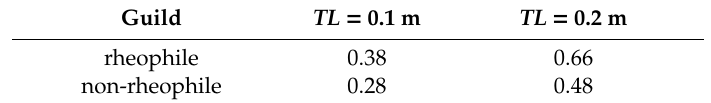
Table 1. Sustained swimming speeds (m s − 1 ) calculated with the equations given by Ebel [1].